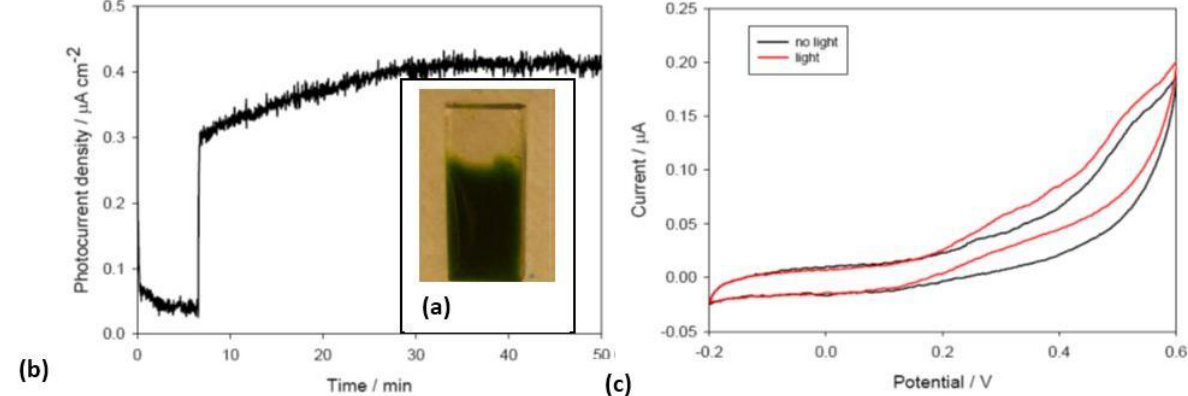
Figure 6. ( a ) Picture of the Thermosynechococcus elongatus biofilm on TiO 2 ; ( b ) Photocurrent measured illuminating T. elongatus biofilm on TiO 2 including a picture of the biofilm on TiO 2 . The rapid increase in current at minute 7 corresponds to the light being switched on; ( c ) Cyclic voltammetry recorded for the same electrode with ( black line ) and without ( red line )